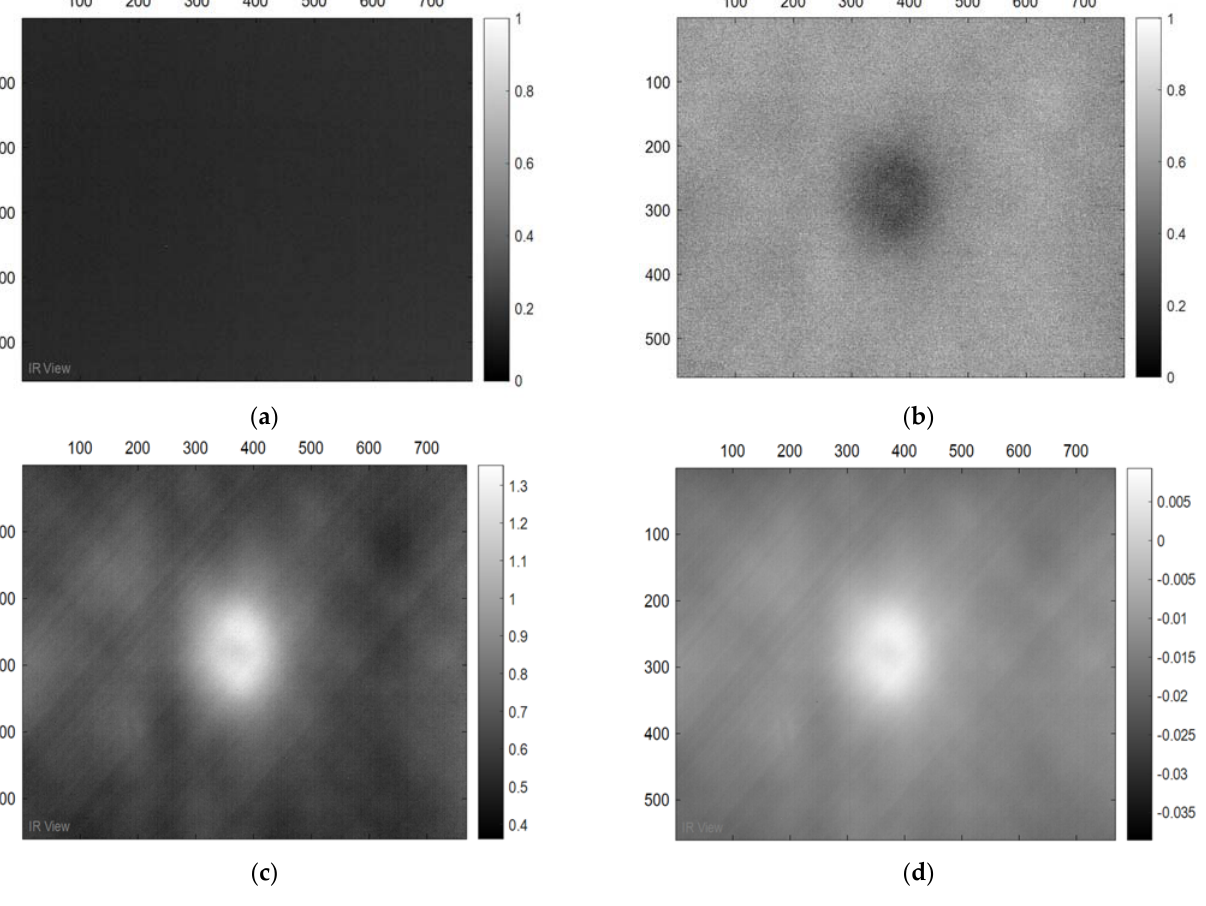
Figure 9. Images Processing Results. ( a ) Cold image. ( b ) Raw Image. ( c ) BCT Image. ( d ) PPT Image.